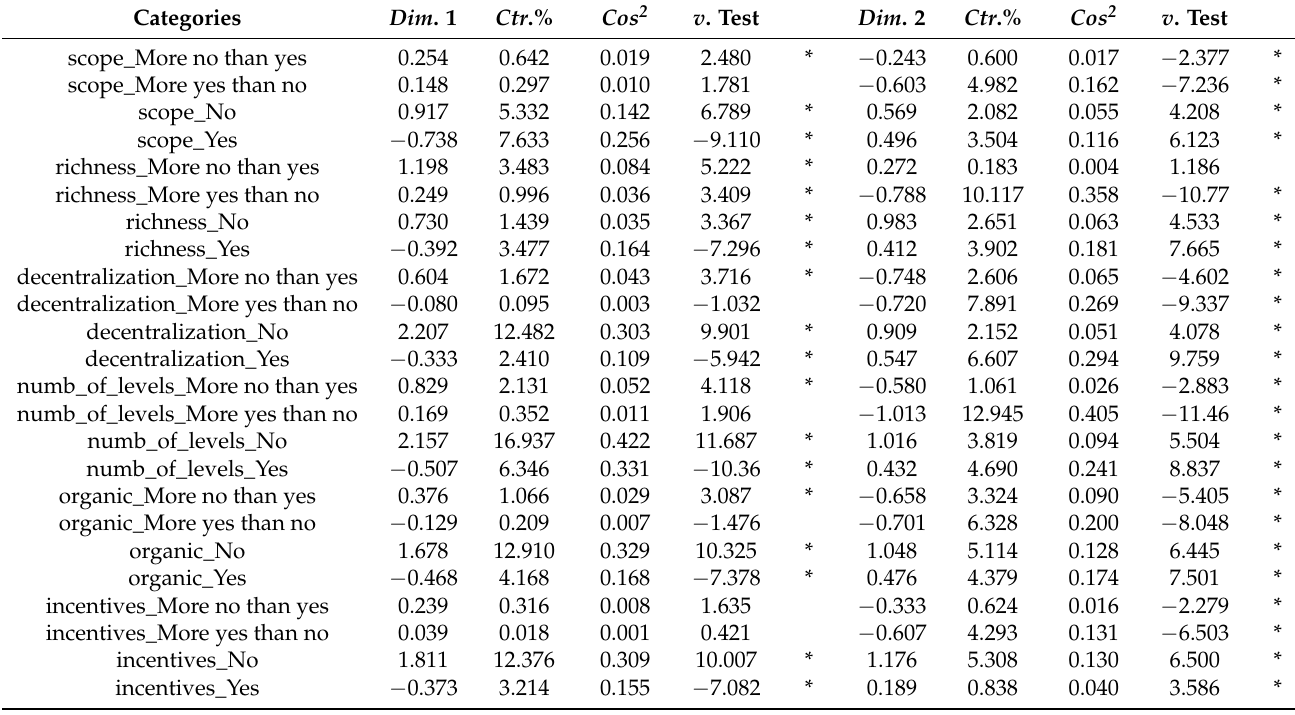
Table 3. MCA active categories. Analytical